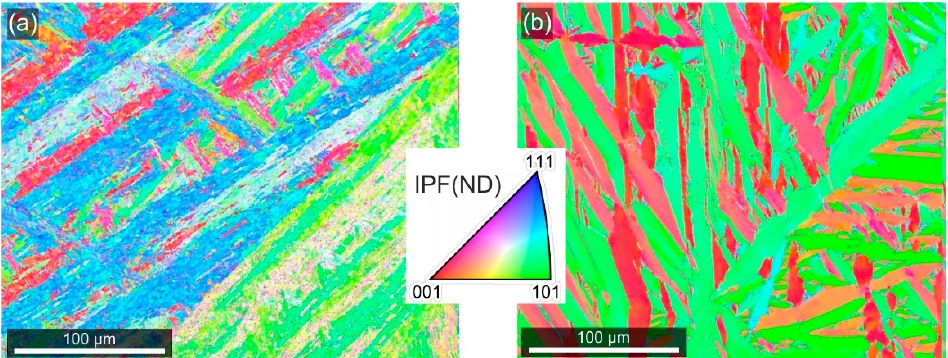
Figure 1. OI-SEM IPF images of martensite morphologies in binary Fe-Ni alloys. ( a ) Lath martensite in Fe-25Ni. ( b ) Plate martensite in Fe-30Ni. For details see text.